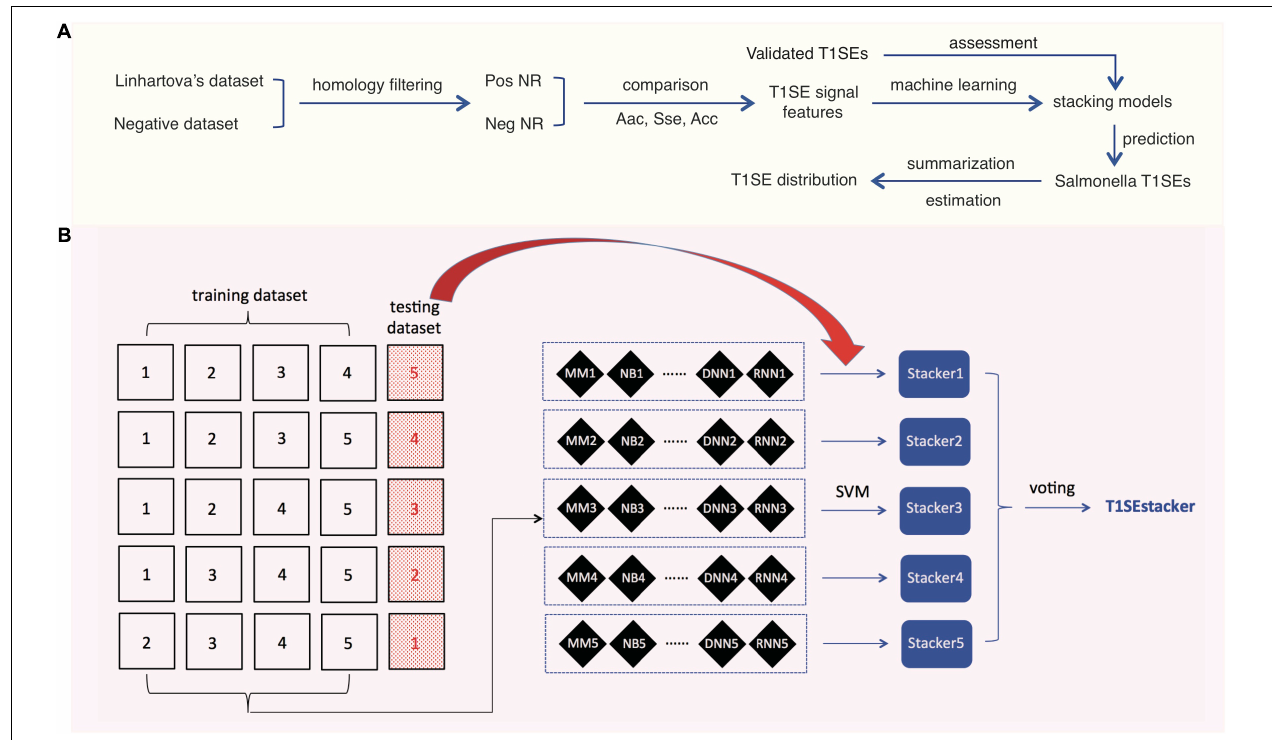
FIGURE 1 | Research design and scheme of the tri-layer staking model T1SEstacker. (A) Research design. Pos, positive; Neg, negative; NR, non-redundant. (B) Tri-layer stacking model. The original positive and negative datasets were fivefold divided and four of them were used as training datasets for training different machine-learning models, e.g., MM, NB, etc. The remaining sub-divided dataset was used as the corresponding testing dataset. For each round of cross-validation, the prediction results of the individual models for the testing dataset were used for training and testing the primary stacker models using SVM with an embedded fivefold cross-validation strategy. Prediction results of the primary stackers were further stacked in T1SEstacker with a voting strategy.